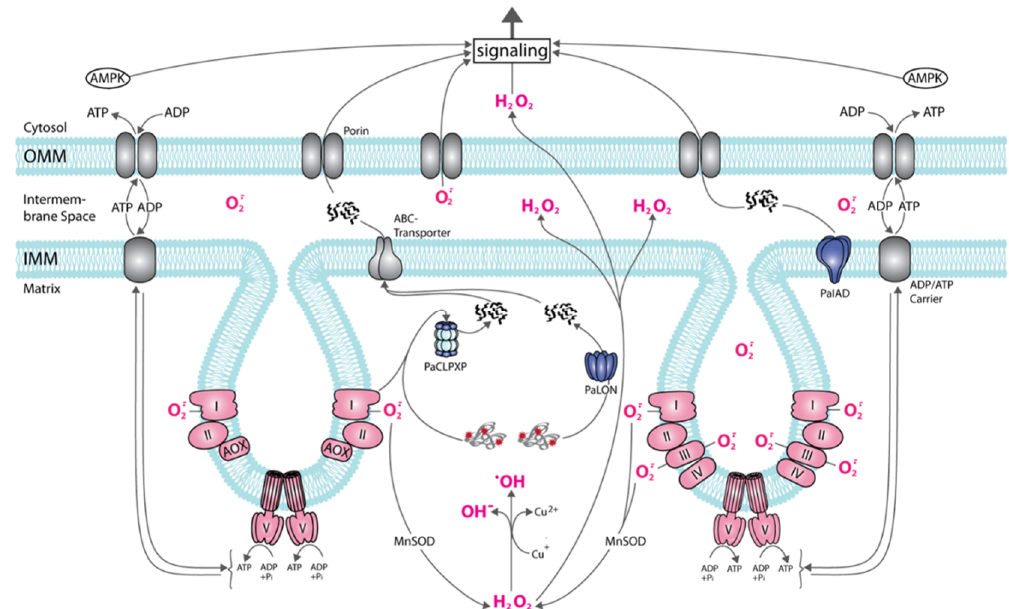
Figure 2. Age-related mitochondrial signaling in P. anserina . The scheme shows a part of a mitochondrion with two cristae formed by the invagination of the inner mitochondrial membrane (IMM). On the right, the standard respiratory chain is part of the IMM, on the left, the alternative respiratory chain with the alternative oxidase (AOX) is displayed. To note: at the standard respiratory chain superoxide is released into the inner space of cristae and into the matrix, at the alternative respiratory chain only into the matrix. In the matrix, superoxide (O − · ) can be transformed into hydrogen peroxide (H 2 O 2 ) that, in the presence of Cu (I) or Fe (II) (for simplicity only Cu (II) is shown) can form the highly toxic hydroxyl radical ( · OH) or can pass the IMM and outer membrane (OMM) phospholipid layer reaching the cytosol. Superoxide in the intermembrane space can be released to the cytoplasm via porins. Damaged (red asterisks) or excessive proteins can be degraded by PaLON, PaCLPXP, PaIAP, or other proteases (not shown) to peptides that can be transported to the cytosol and are effective in the induction of responses. The energetic status (AMP/ATP ratio) of the cell can be sensed by AMPK and induces a variety of molecular responses.